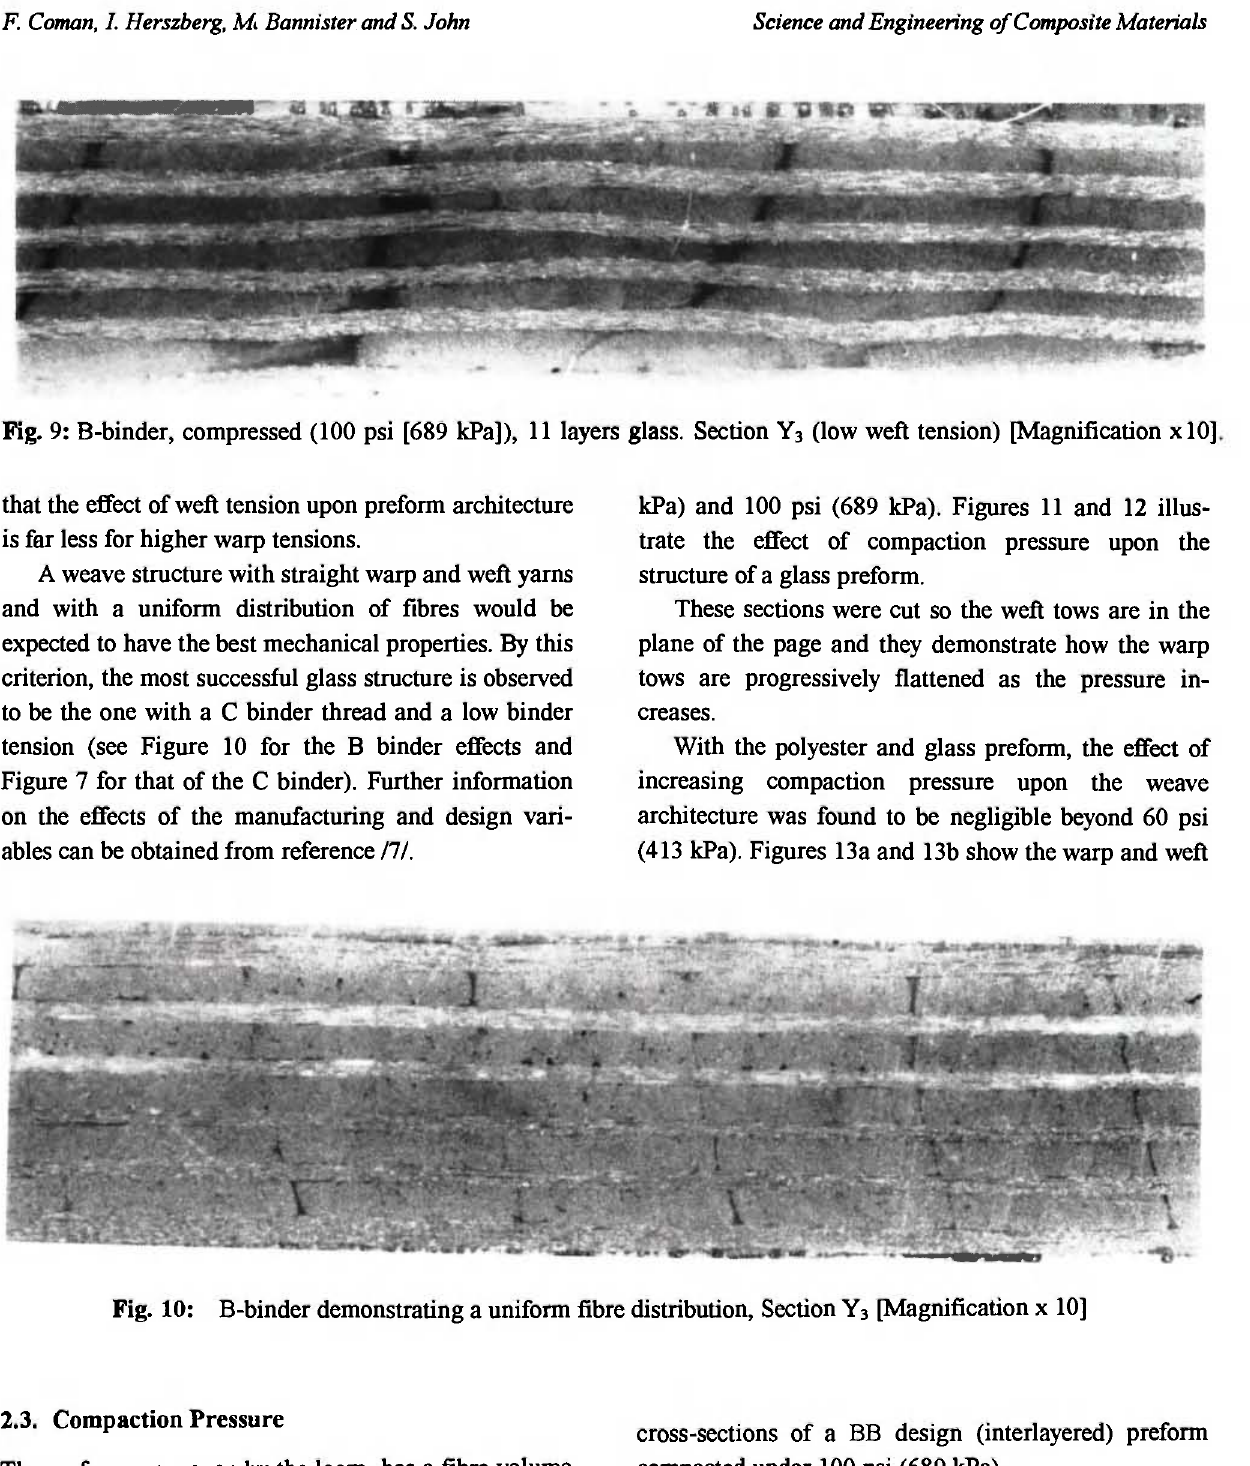
Fig. 10: B-binder demonstrating a uniform fibre distribution, Section Y